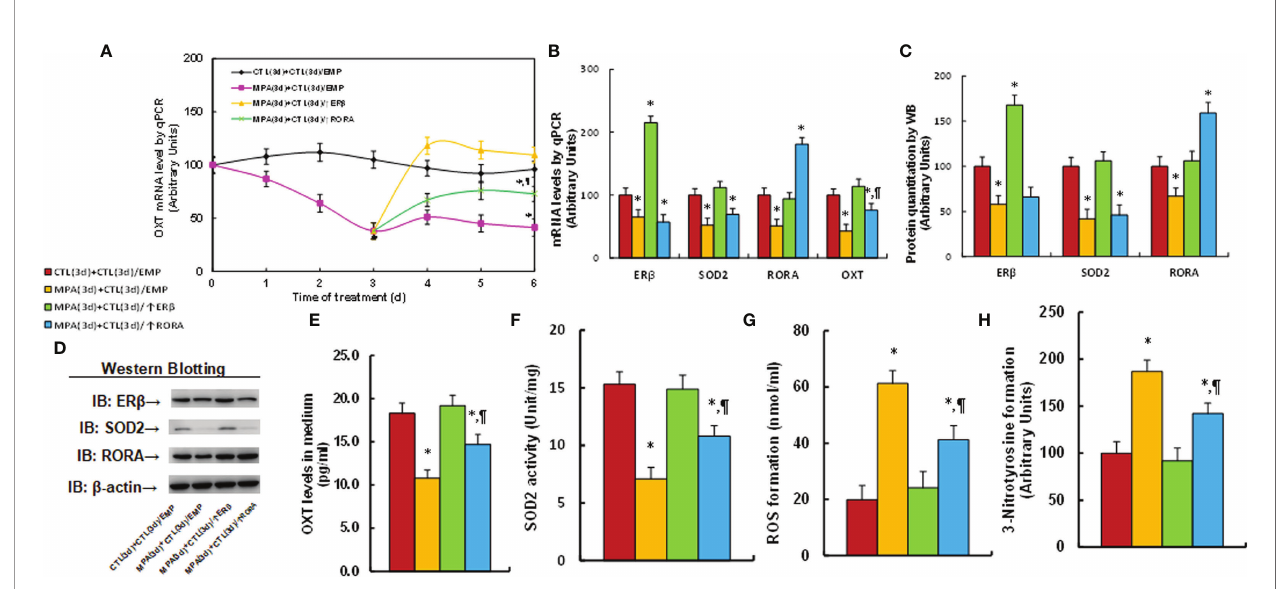
FIGURE 1 | Transient MPA treatment causes persistent OXT suppression and oxidative stress; ER b expression completely, while RORA expression partly, reverses this effect. Mouse hypothalamic neurons were treated with either 10 m M MPA or vehicle control (CTL) for 3 days. The cells were infected by empty (CTL), ER b ( ↑ ER b ), or RORA ( ↑ RORA) lentivirus on day 3 and the cells were then cultured without MPA for another 3 days in the presence of 1% FBS before being harvested for biological assays. (A) OXT mRNA levels on different time points, n=4, * P < 0.05, vs. day 0 group; ¶ P < 0.05, vs. day 3 group. (B – H) Biological assays on day 6. (B) mRNA levels, n=4. (C) Protein quantitation, n=5. (D) Representative western blots for (C) . (E) OXT levels in culture medium, n=5. (F) SOD2 activity, n=5. (G) ROS generation, n=5. (H) 3-nitrotyrosine generation, n=5. * P < 0.05, vs. CTL(3d)+CTL(3d)/EMP group; ¶ P < 0.05, vs. MPA(3d)+CTL(3d)/EMP group. Data were expressed as mean ±